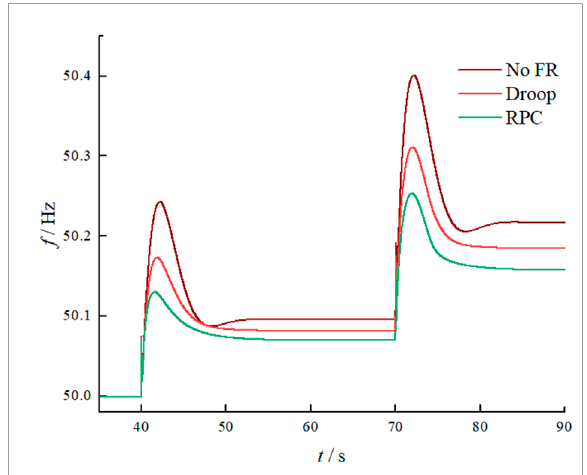
FIGURE 10 Sending end grid frequency in the event of 100 MW load shedding.